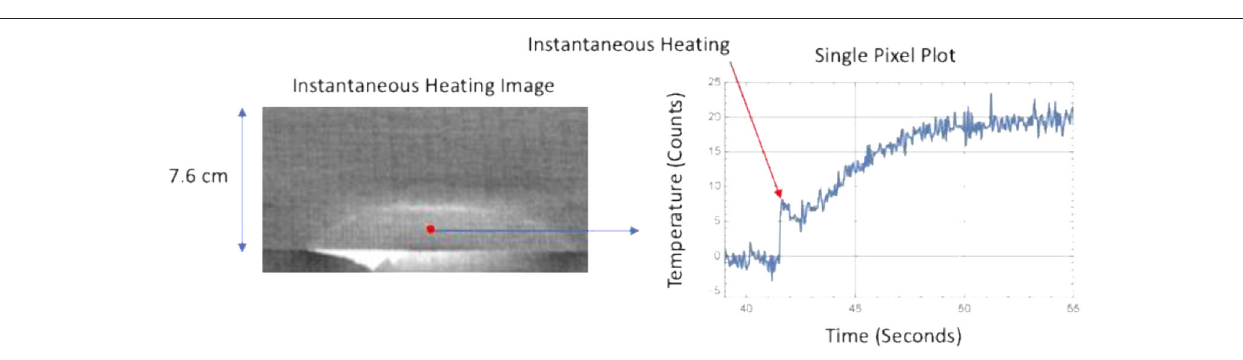
FIGURE 6 | Single pixel plot of surface heating showing instantaneous heating response for large